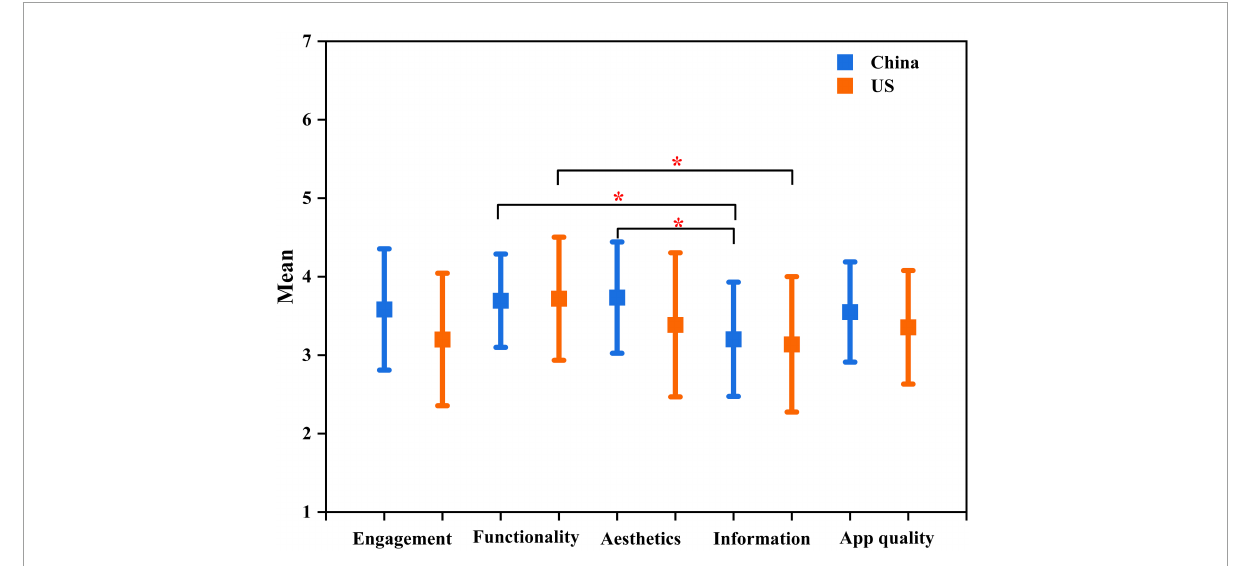
FIGURE4 Mean difference in the engagement, functionality, esthetics, information, and overall app quality scores between included apps from the United States and China. * p <